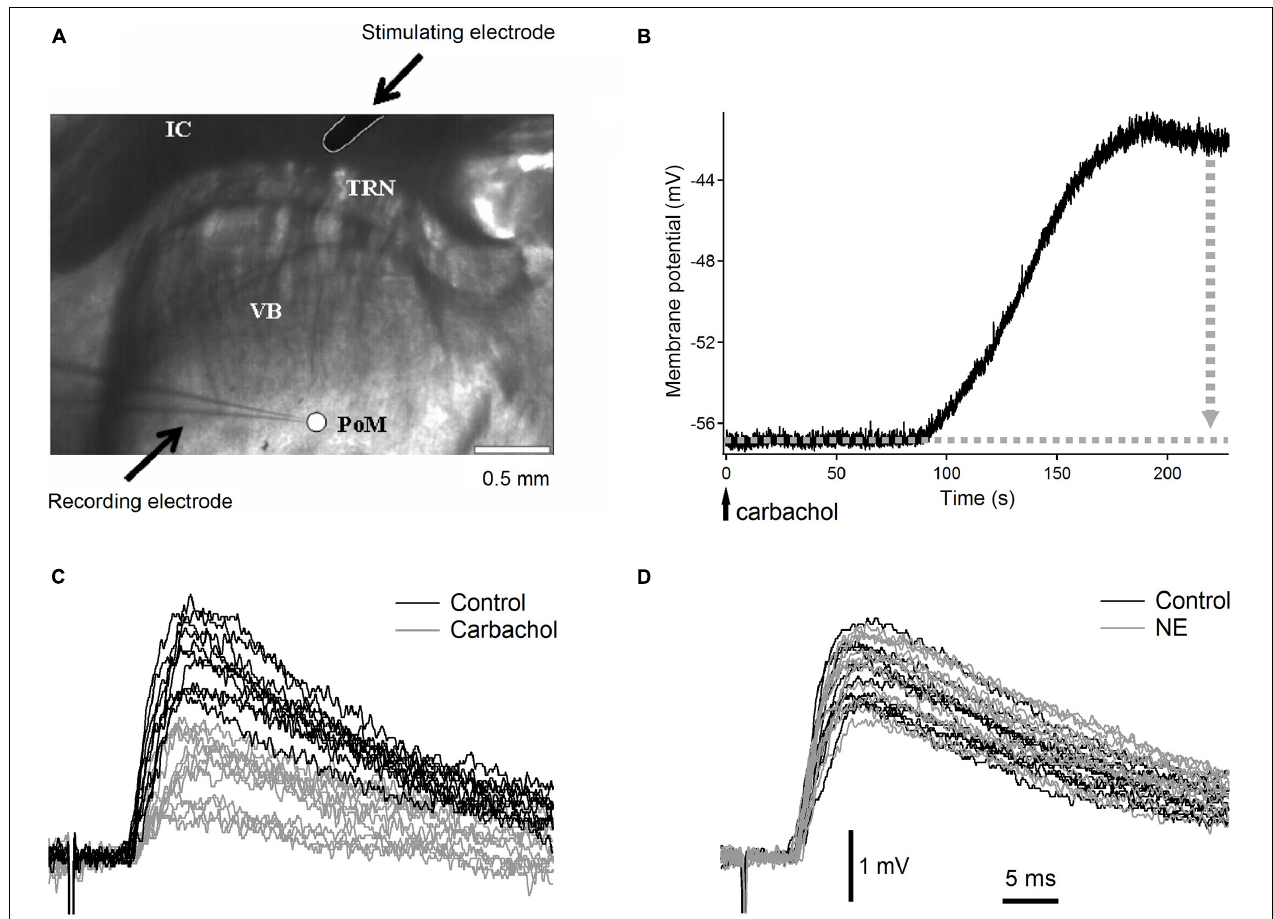
FIGURE 1 | Raw experimental data. (A) Low magnification (1.4 × ) image of the somatosensory thalamic area with recording electrode in posteromedial nucleus and stimulation electrode in the internal capsule. VB, ventrobasal nucleus with characteristic stripes of dense fibers; PoM, posteromedial nucleus recognized as uniform, brighter area; IC, internal capsule; TRN, thalamic reticular nucleus; arrows point to recording and stimulating electrodes. Scale bar is 0.5 mm. (B) Typical depolarization of a PoM cell after application of cholinergic agonist carbachol. The vertical dotted gray arrow indicates the manual compensation of membrane potential shift by adding negative DC current. (C) Examples of raw EPSPs evoked in a PoM cell by the 1st impulse of the five-pulse train (0.033 Hz train repetition rate) stimulating cortico-thalamic axons in the internal capsule. Black traces show EPSPs in the control condition (with the ACSF containing both GABA A and GABA B inhibitors – 10 µ M bicuculline and 2 µ M CGP55845 respectively). Gray traces show EPSPs after adding carbachol (7 µ M) to the ACSF. (D) Raw EPSPs evoked by the 1st stimulation pulse in the control condition (black traces) and after adding norepinephrine (100 µ M) to the ACSF (gray traces). In this case, as with the study of each noradrenergic substance in this work, both control and test ACSFs contained in addition to GABA A and GABA B inhibitors also an antioxidant – 40 µ M sodium ascorbate. In (C,D) all EPSPs were recorded at similar membrane potential between –56 and –57 mV but their individual baselines varied within about 1 mV range. To better show inter-trial fluctuations of EPSPs amplitude, all EPSP traces were adjusted in (C,D) to the same baseline. Vertical and horizontal scales for (C,D) are indicated by black bars at the bottom of (D)